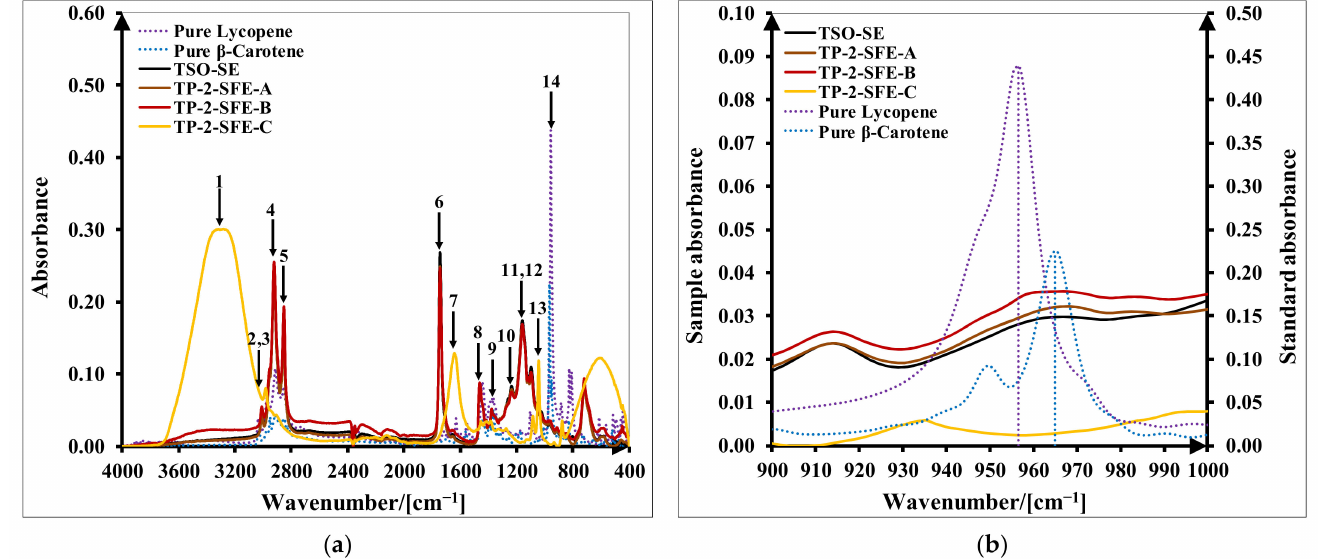
Figure 7. FT–IR spectra of SFE fractions (SFE-A, SFE-B, SFE-C) obtained from tomato pomace (TP) with operating parameter set (2) at 450 bar, 70 ◦ C and 11 kg/h (TP-2-SFE): ( a ) 400–4000 cm − 1 region; ( b ) 900–1000 cm − 1 region.